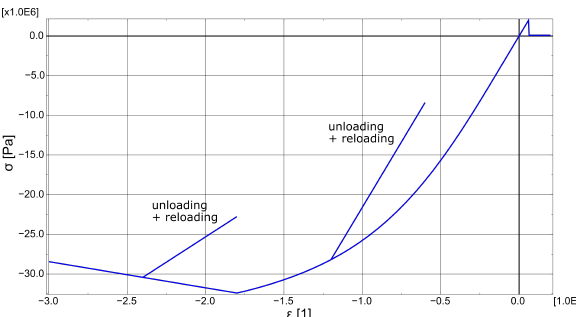
Figure 7. Behaviour of the proposed model in the uniaxial stress state.